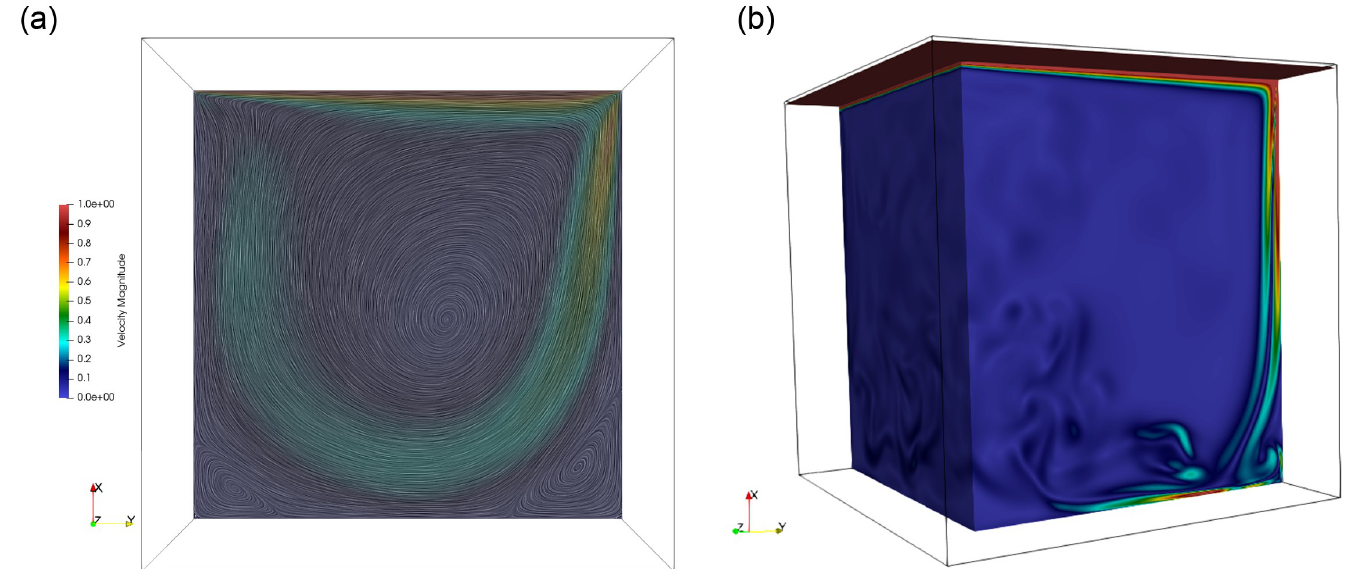
Fig 1. Visualization of simulation results for the lid-driven cavity. Left image: velocity norm and streamlines of the steady-state results at Re = 1000, on the plane defined by z = 0. Right image: vorticity norm on a selected surface at an instantaneous time step for the fully developed flow at Re = 10000.